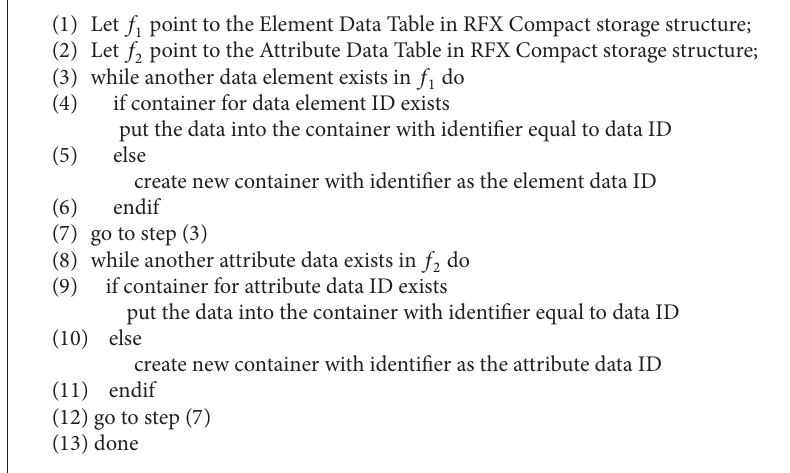
Algorithm 1: Algorithm for the Data Organizer.